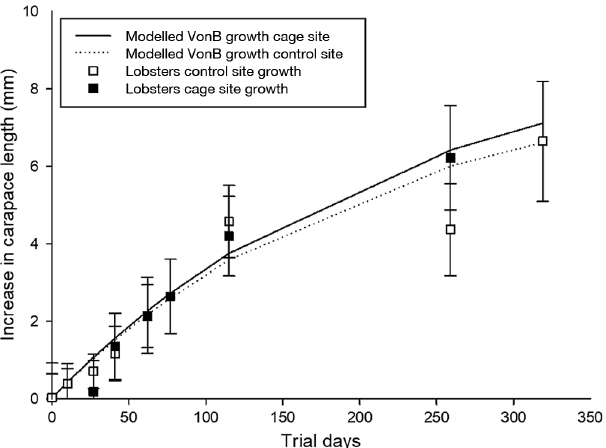
Fig. 6. Growth curves of lobsters between control and cage stations, based on measured values (mean ± SD). Von Berta- lanffy growth functions plotted by trial day and increases in carapace length for 319 d of the trial. Parameters estimated for the cage site were L ∞ = 9.43, K = 0.0044, t 0 = −0.4318, and control site L ∞ = 8.44, K = 0.0048, t 0 =